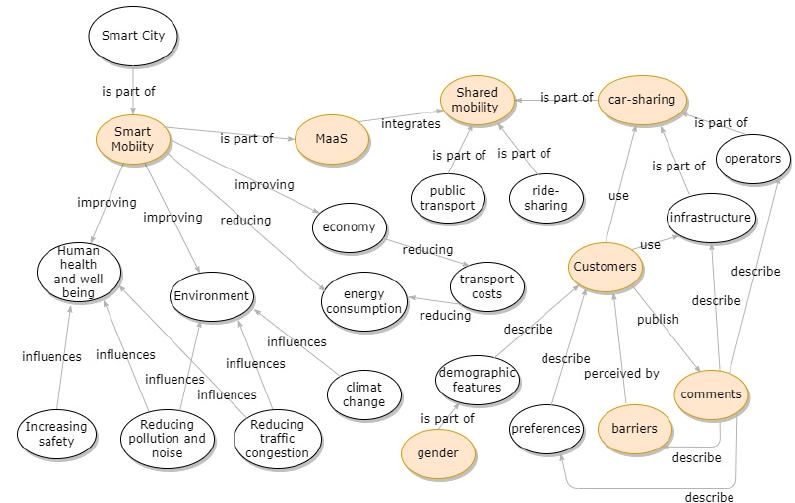
Figure 1. Research topics related to this case study of car-sharing.